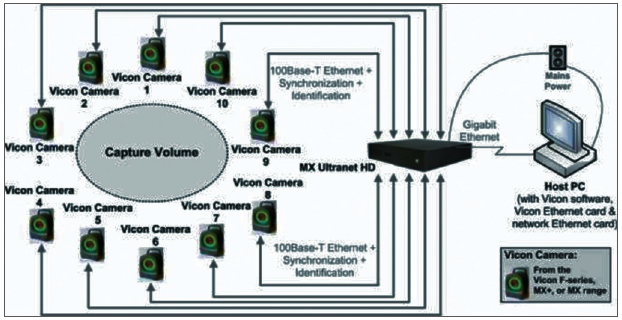
Figura 1. Vista esquemática de como o sistema de captura Vicon opera.